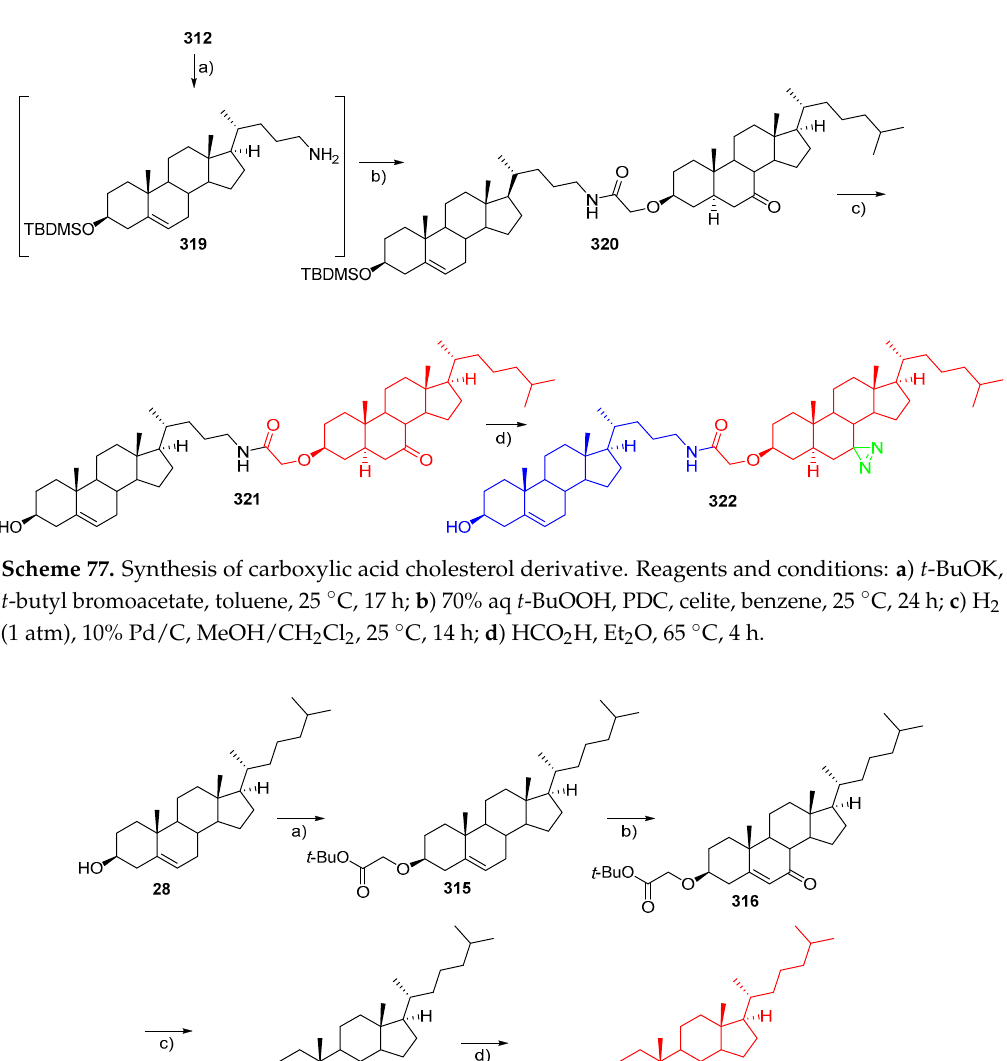
Scheme 77. Synthesis of carboxylic acid cholesterol derivative. Reagents and conditions: a ) t -BuOK, t -butyl bromoacetate, toluene, 25 °C, 17 h; b ) 70% aq t -BuOOH, PDC, celite, benzene, 25 °C, 24 h; c )